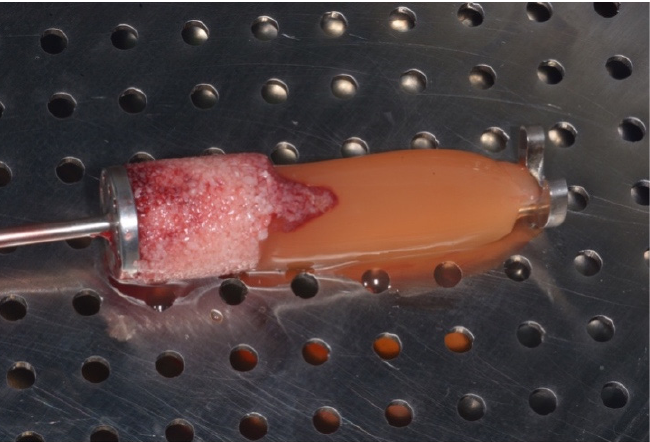
Figure 3. The particulate bone substitute mixed with the CGF (“sticky bone”) prepared with the SBPD ® after centrifugation.